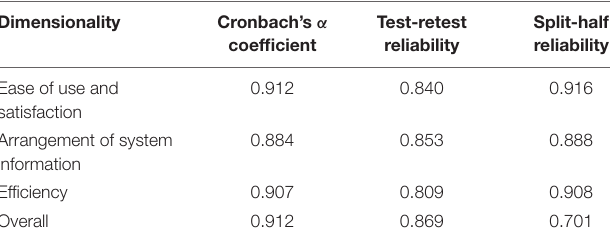
TABLE 10 | Reliability of each dimension of the